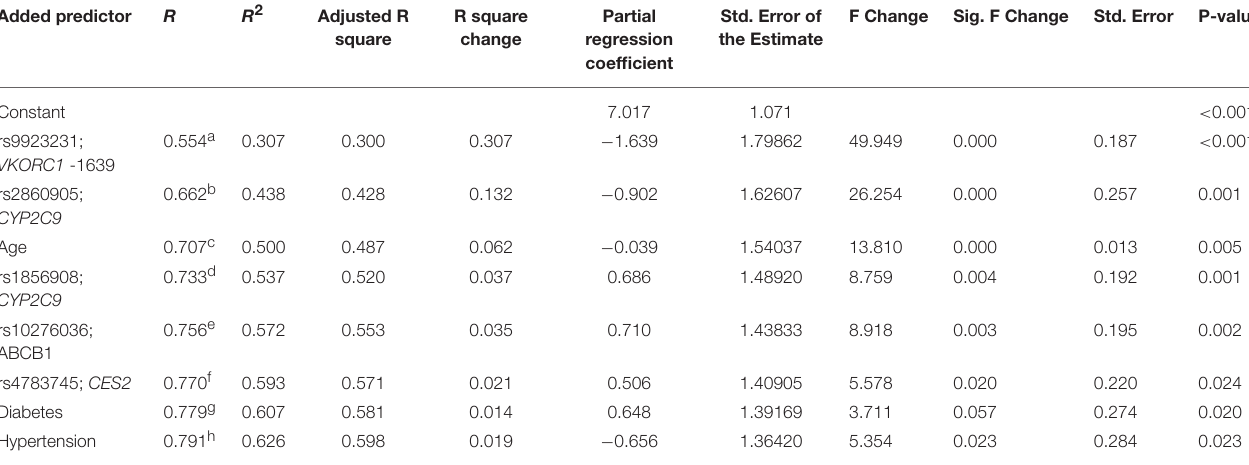
TABLE 5 | Stepwise regression analysis for Model 2 which includes rs 2860905 (excluding CYP2C9 * 2 and CYP2C9 * 3 ). Added predictor R R 2 Adjusted R